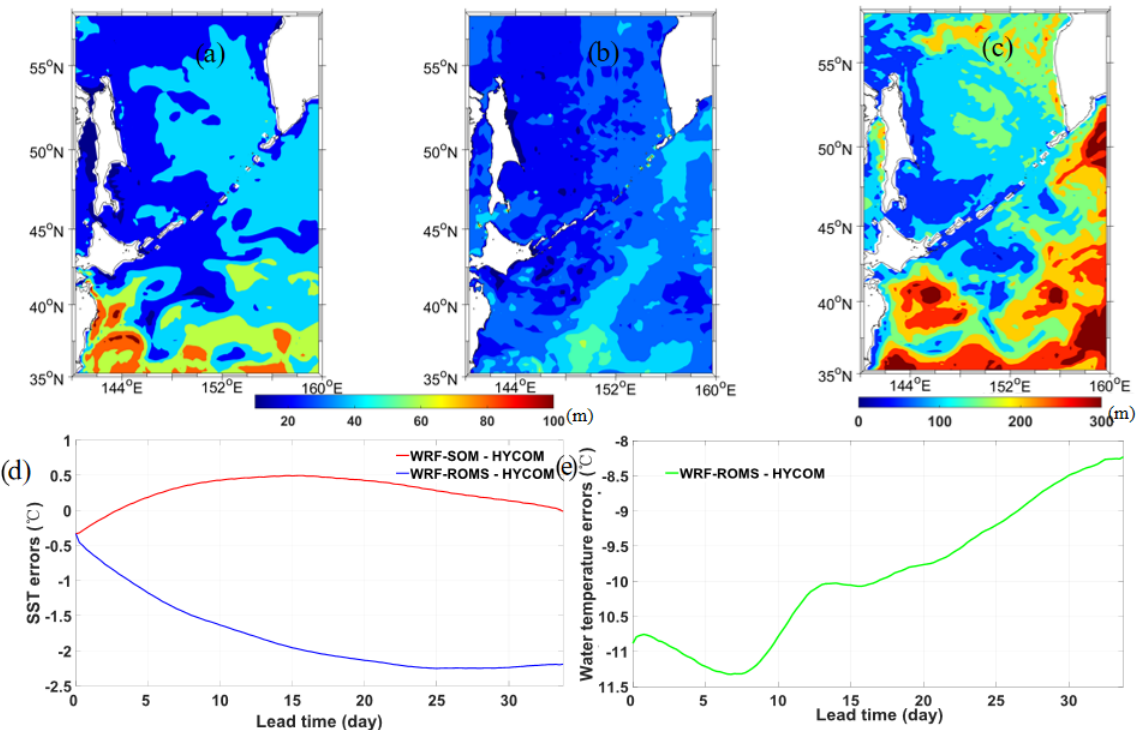
Figure 5. The spatial distribution of the mixed layer depth in the cold deviation area in the (a) Ocean Reanalysis, (b) WRF-SOM, and (c) WRF-ROMS of total 142 forecast cases from 19 July to 31 December 2020 averaged in the 34d forecast period. The time series of averaged water temperature errors at the (d) surface in WRF-SOM (red) and WRF-ROMS (blue), and the (e) subsurface (300–400m) in WRF-ROMS (green) against HYCOM reanalysis in the cold deviation area.